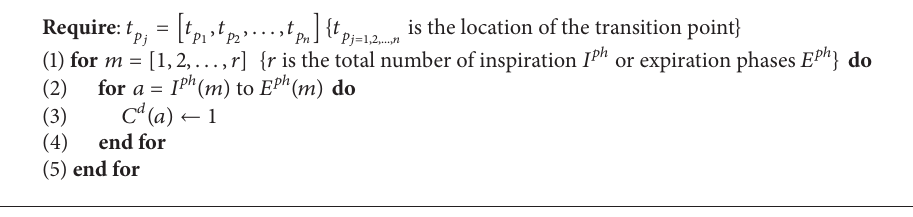
Algorithm 1: Calculate 𝐶 𝑑 .